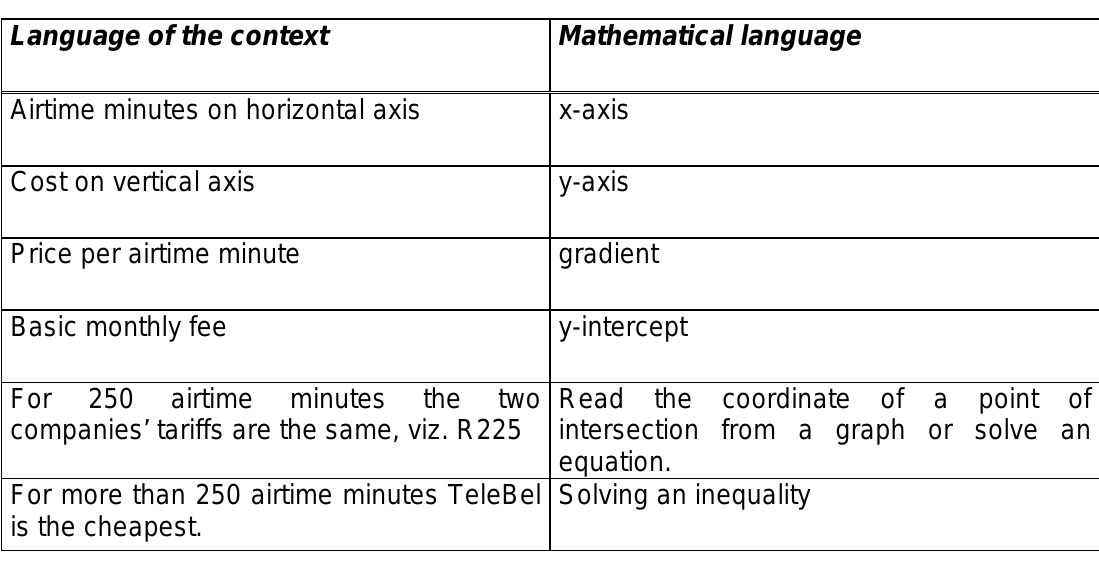
Language of the context versus mathematical